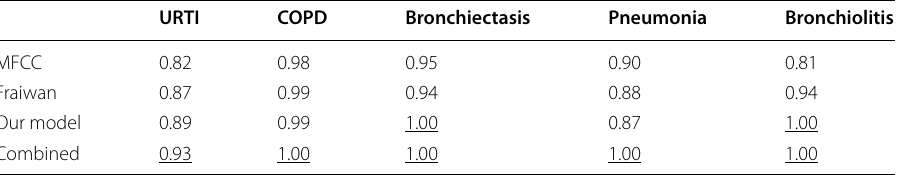
Table 2 AUROC obtained by means of the different models in the binary classification for each pathology URTI COPD The best score for each pathology is underlined